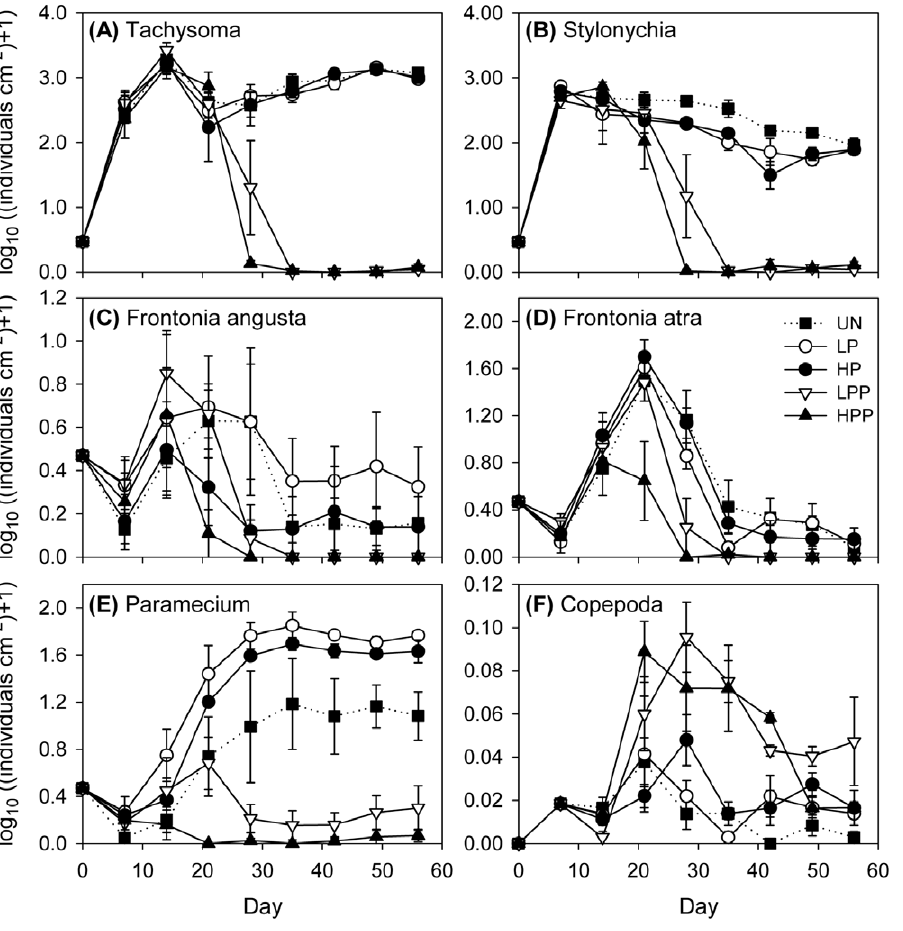
Figure 3. Metacommunity abundances of all prey species and of the predatory copepod. Treatment abbreviations and symbols as in Fig. 2. Abundances (log 10 transformed) are means 6 SE